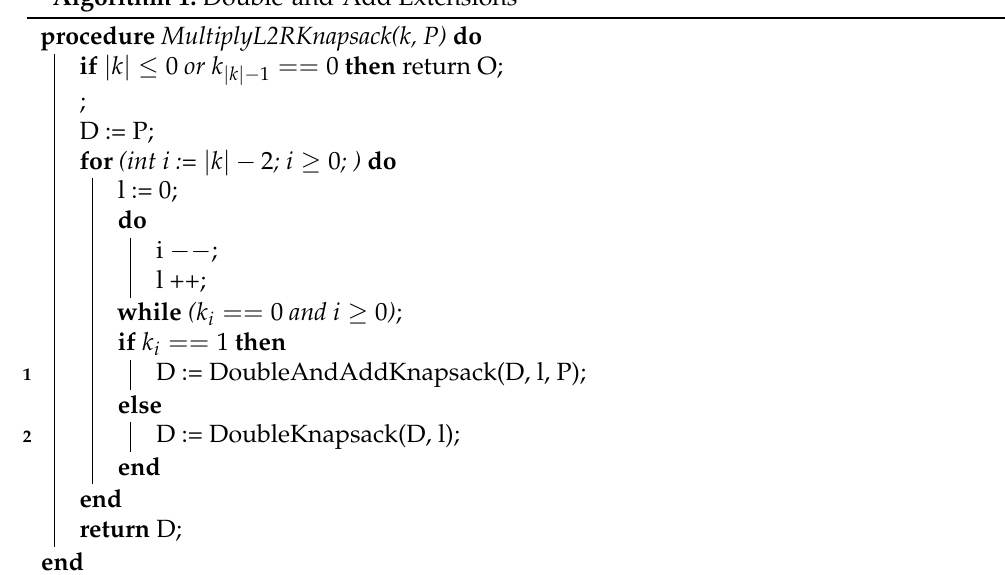
Algorithm 1: Double-and-Add